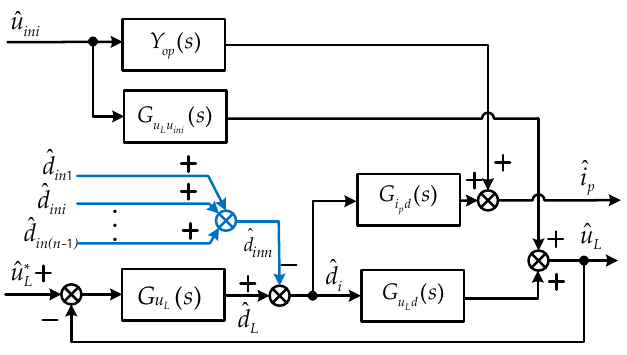
Figure 5. Control block diagram of the n -th DAB converter. From Figure 5, we can see that the compensation in phase shift ratio d inn for the n -th DAB converter is different from d ini ( i = 1, 2 . . . n − 1) for the i -th DAB converter as shown in control block diagram, the close-loop input admittance Y L_n ( s ) of the n -th DAB module is